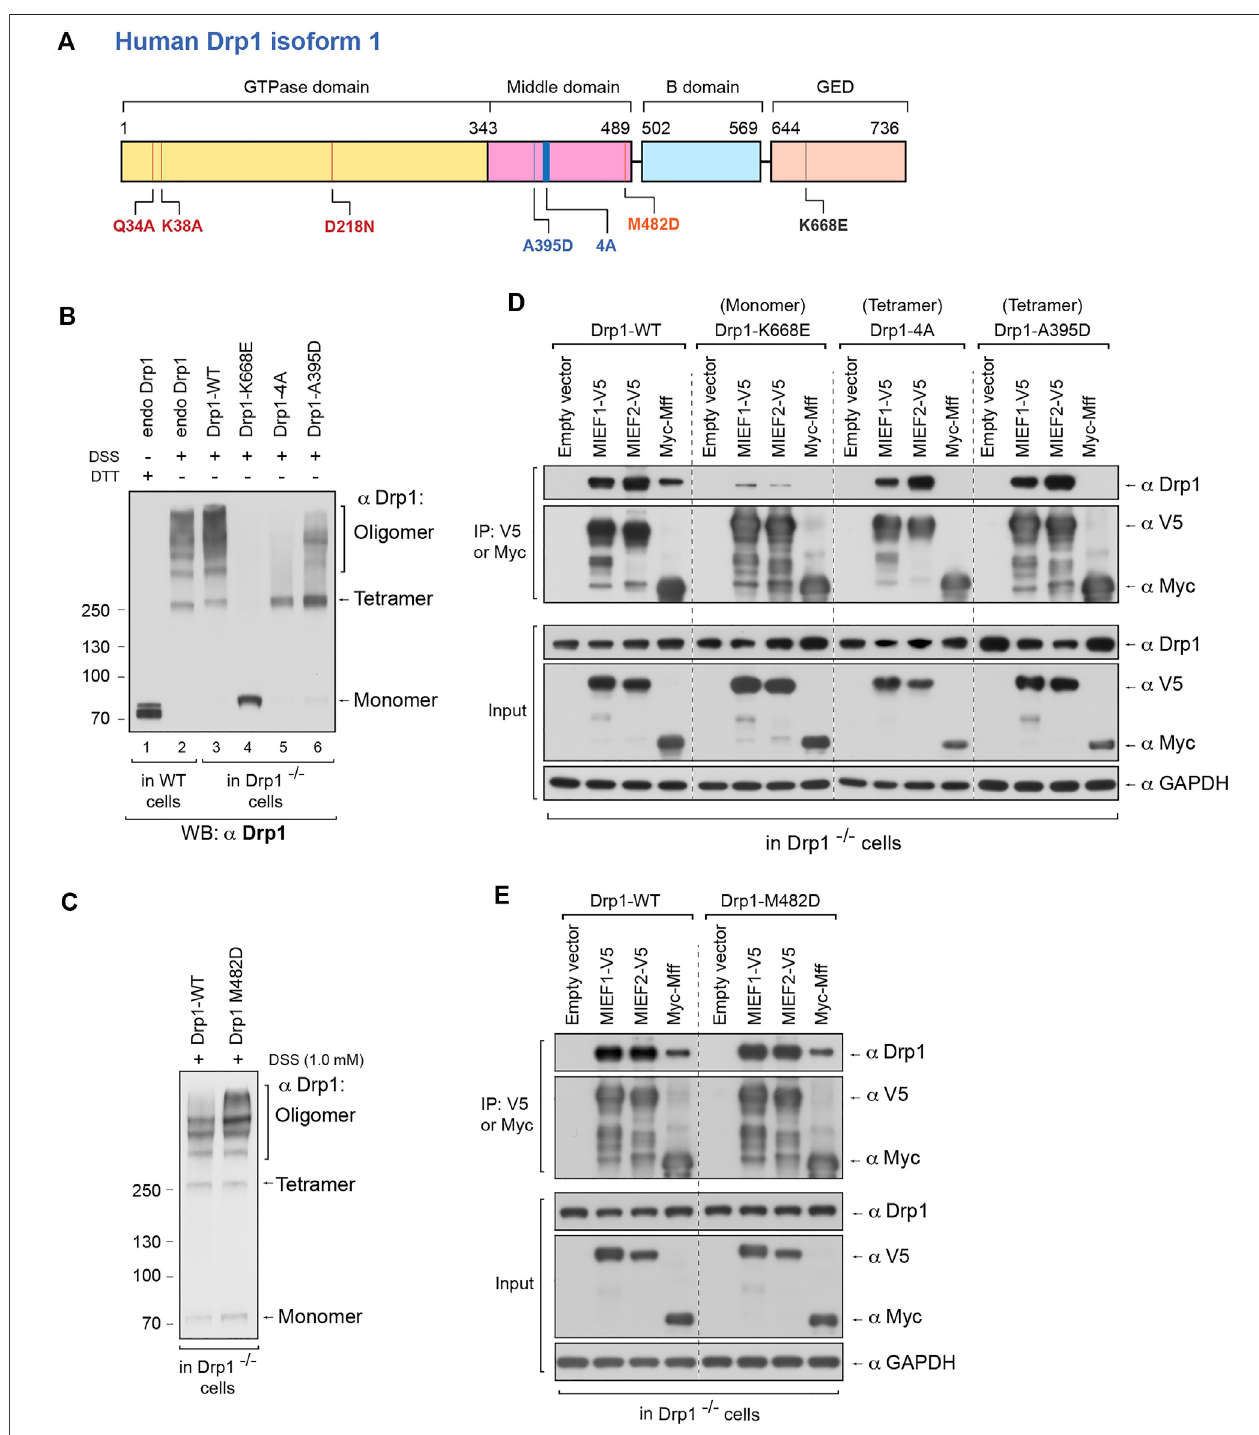
FIGURE3| Theself-assemblystateofDrp1differentiallyregulatesitsbindingtothemitochondrialreceptorsMIEFsandMff. (A) Schematicrepresentationofhuman Drp1 protein structure and functional domains. The positions of Drp1 mutations used in this study are indicated. (B) The oligomeric states of Drp1-WT, Drp1-K668E, Drp1-4A, and Drp1-A395D.Drp1 − / − 293Tcells were transfected withuntagged wild-type Drp1 (Drp1-WT) or untagged Drp1 mutants as indicated for 18 h, treated with in vivo chemical crosslinker DSS (1 mM) for 3 h and analyzed by Western blotting with anti-Drp1 antibody. Endogenous Drp1 in wild-type 293T cells (endo Drp1) and exogenous Drp1-WT in Drp1 − / − 293T cells were used as controls. (C) The oligomeric state of Drp1-M482D. Drp1 − / − 293T cells were transfected with untagged Drp1-WT (control) or Drp1-M482D as indicated for 18 h and incubated with DSS (1 mM) for 3 h at room temperature, followed by Western blotting with anti-Drp1